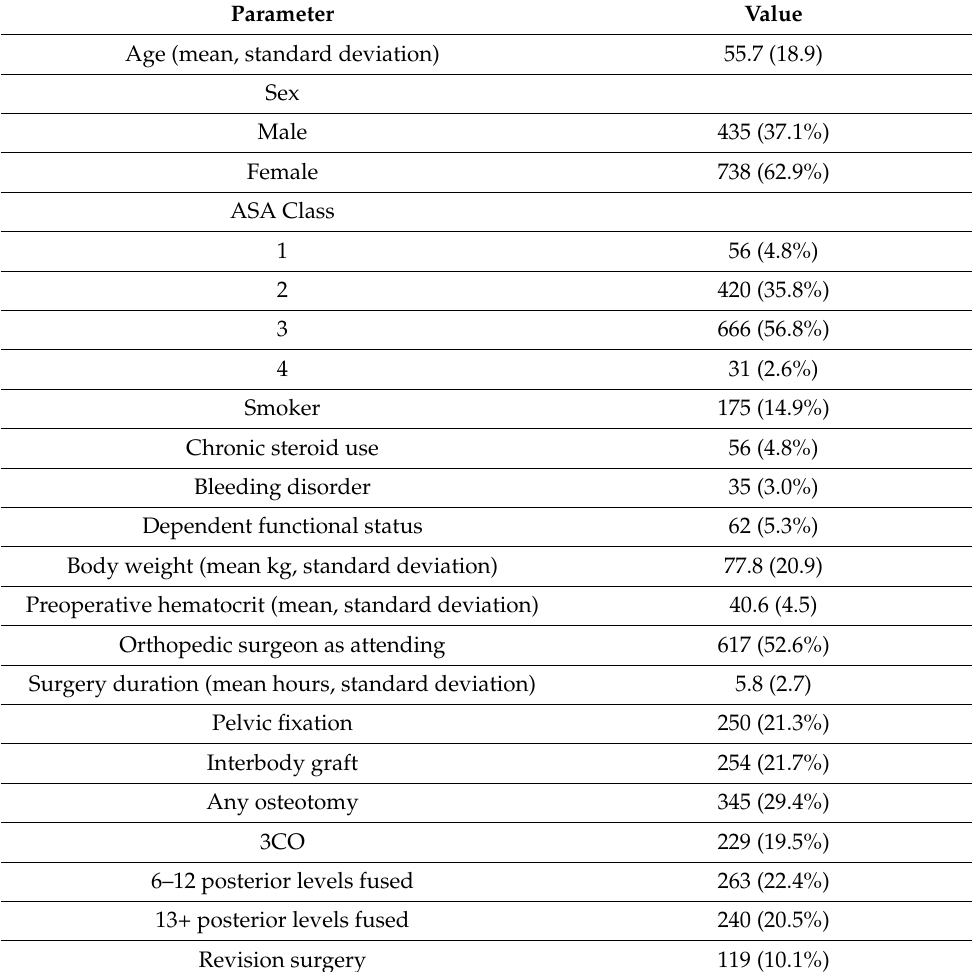
Table 1. Baseline and operative characteristics of all patients.